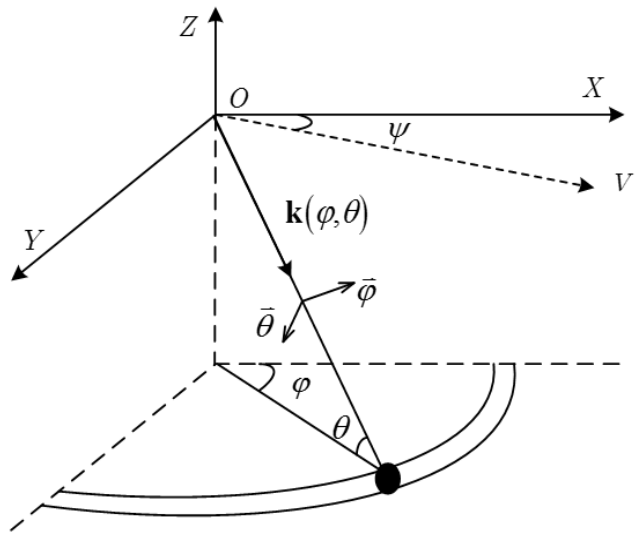
Figure 1. Schematic diagram of airborne radar system.